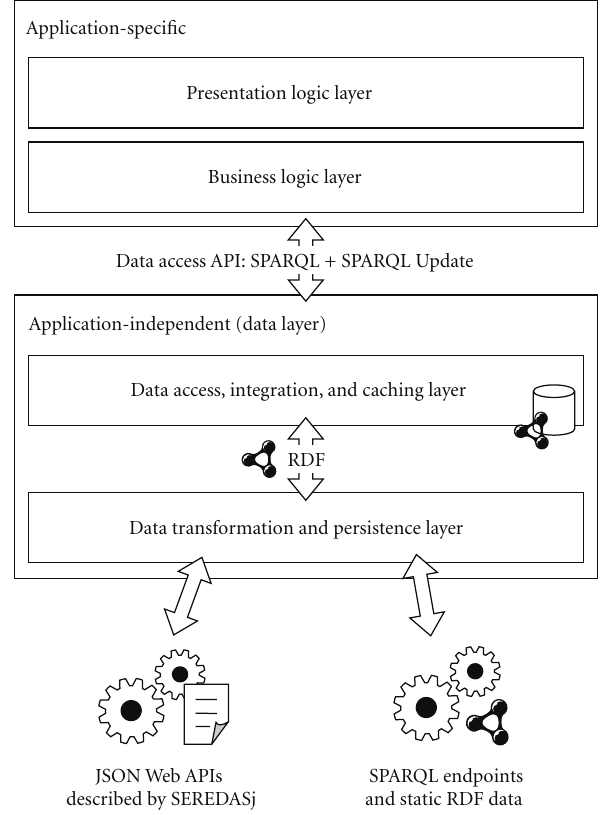
Figure 2: A reference model for integrating Web APIs into the Web of